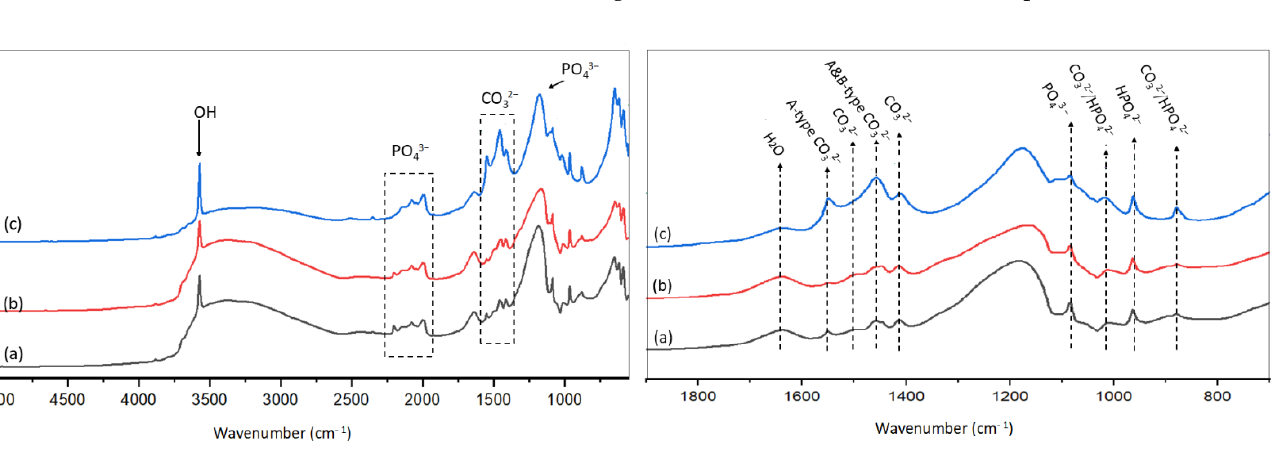
Figure 6. IR spectra for ( a ) HAp-S, ( b ) HAp-D, and ( c ) HAp-R ( left ) and zooms of the IR spectra for ( d ) HAp-S, ( e ) HAp-D and ( f ) HAp-R ( right ).